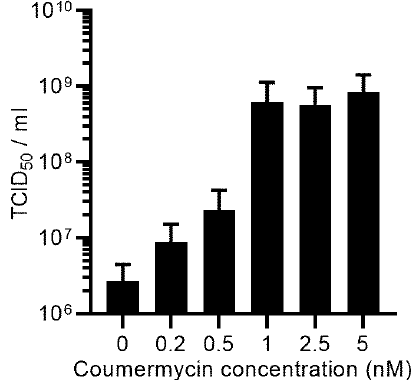
Figure 6. The infected SF-BMAdR- λ R-GyrB-PS-174-12A cells with AdPS- ( n = 2) were induced with different concentrations of coumermycin at 5 hpi. The virus progeny was measured by the TCID 50 assay in duplicate, expressed as TCID 50 /mL, and shown as mean ± SEM.